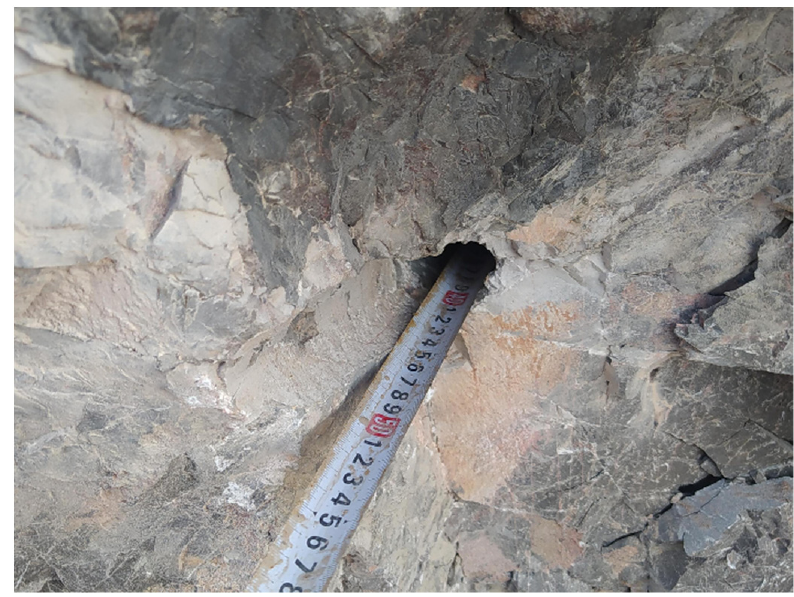
Figure 10. Measurement of residual hole length. Table 7. Statistics of cutting blasting results.